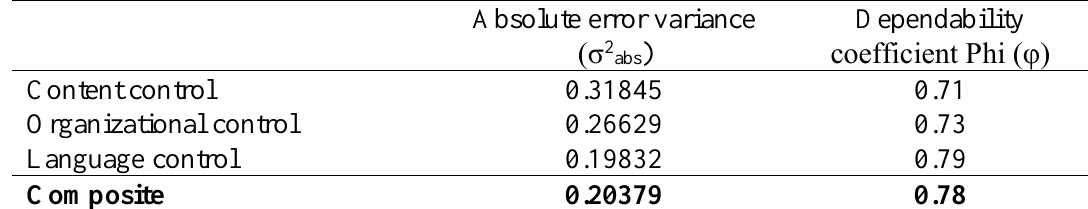
D-study Score Dependability by scale and composite (2 tasks, 2